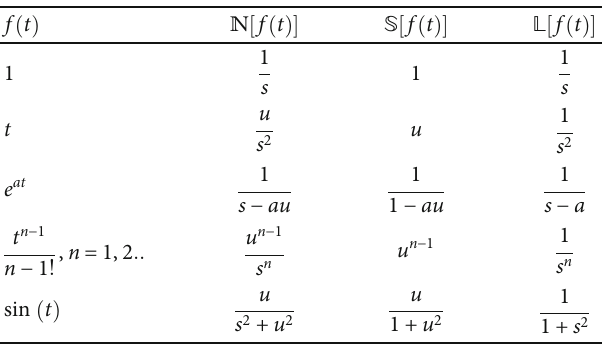
Table 1: Relation between ℕ -transforms, Sumudu transform, and Laplace